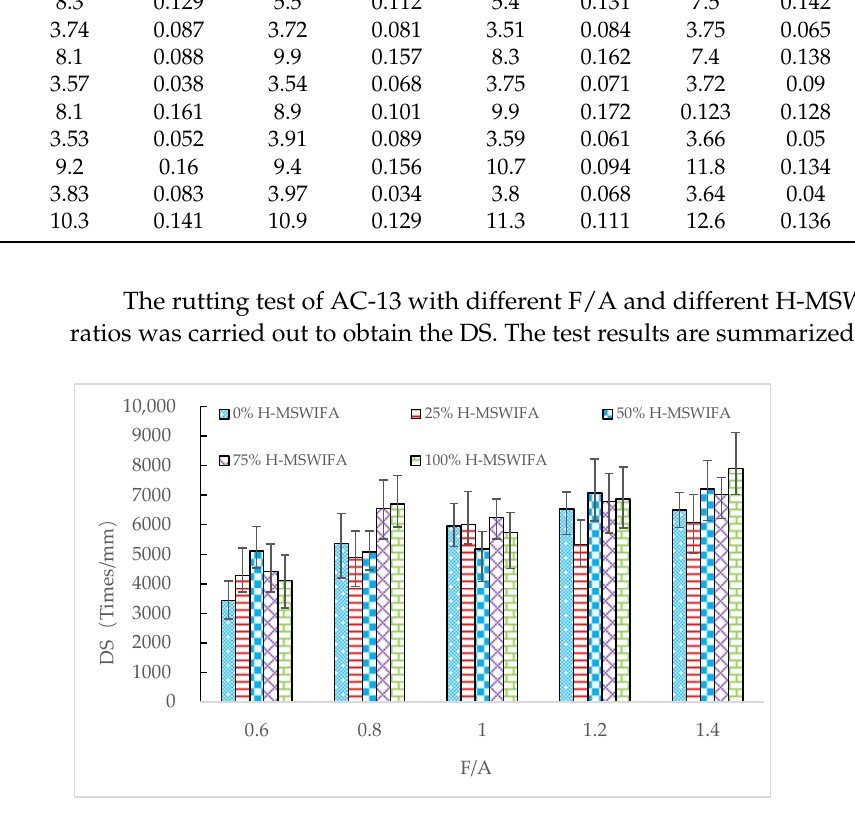
Figure 13. The DS of AC-13.